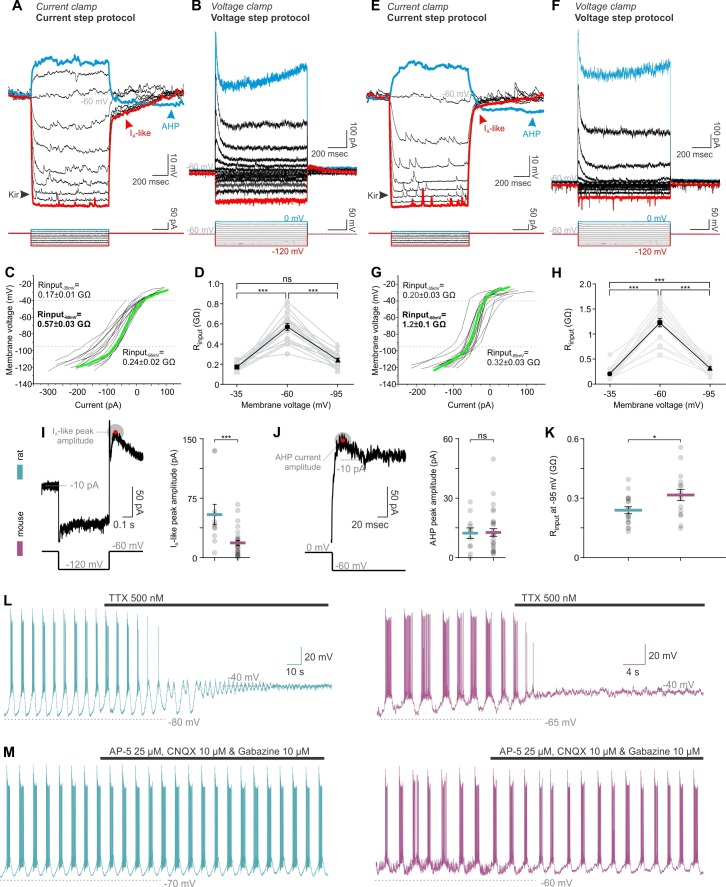
TIDA neurons have similar membrane properties, and exhibit similar sensitivity to tetrodotoxin (TTX) and synaptic blockade in both rats and mice.(A,E) Current and (B,F) voltage step protocols identify characteristic rat (A–D) and mouse (E–H) TIDA cell conductances, namely the K+-mediated inward rectification (Kir), an A-like current (IA) and the depolarization-induced after hyperpolarization (AHP). (,G) Input resistance of TIDA neurons across membrane voltage reveals a sigmoidal plot in both species. (D,H) Higher input resistance at −60 mV in both rat (n = 18) and mouse (n = 16) TIDA neurons (one-way ANOVA with Bonferroni as post-hoc test). (I) Quantification of the A-like current and (J) the AHP current (n = 11 and 30 per group). (K) Comparison of the Rinput at −95 mV, as an indicator of the Kir current activity. (L) Application of the antagonist of voltage-gated Na+ channels, TTX, abolished the oscillation and switched it to a persistent UP state in rat (blue; n = 32) as well as in mouse (purple; n = 22) TIDA neurons. (M) Oscillation persists in both rat (n = 11) and mouse (n = 6) TIDA neurons under fast ionotropic blockade, using AMPA and NMDA glutamate receptor blockers combined with Gabazine as a GABAA receptor blocker. (A–D), rat and (E–H), mouse.